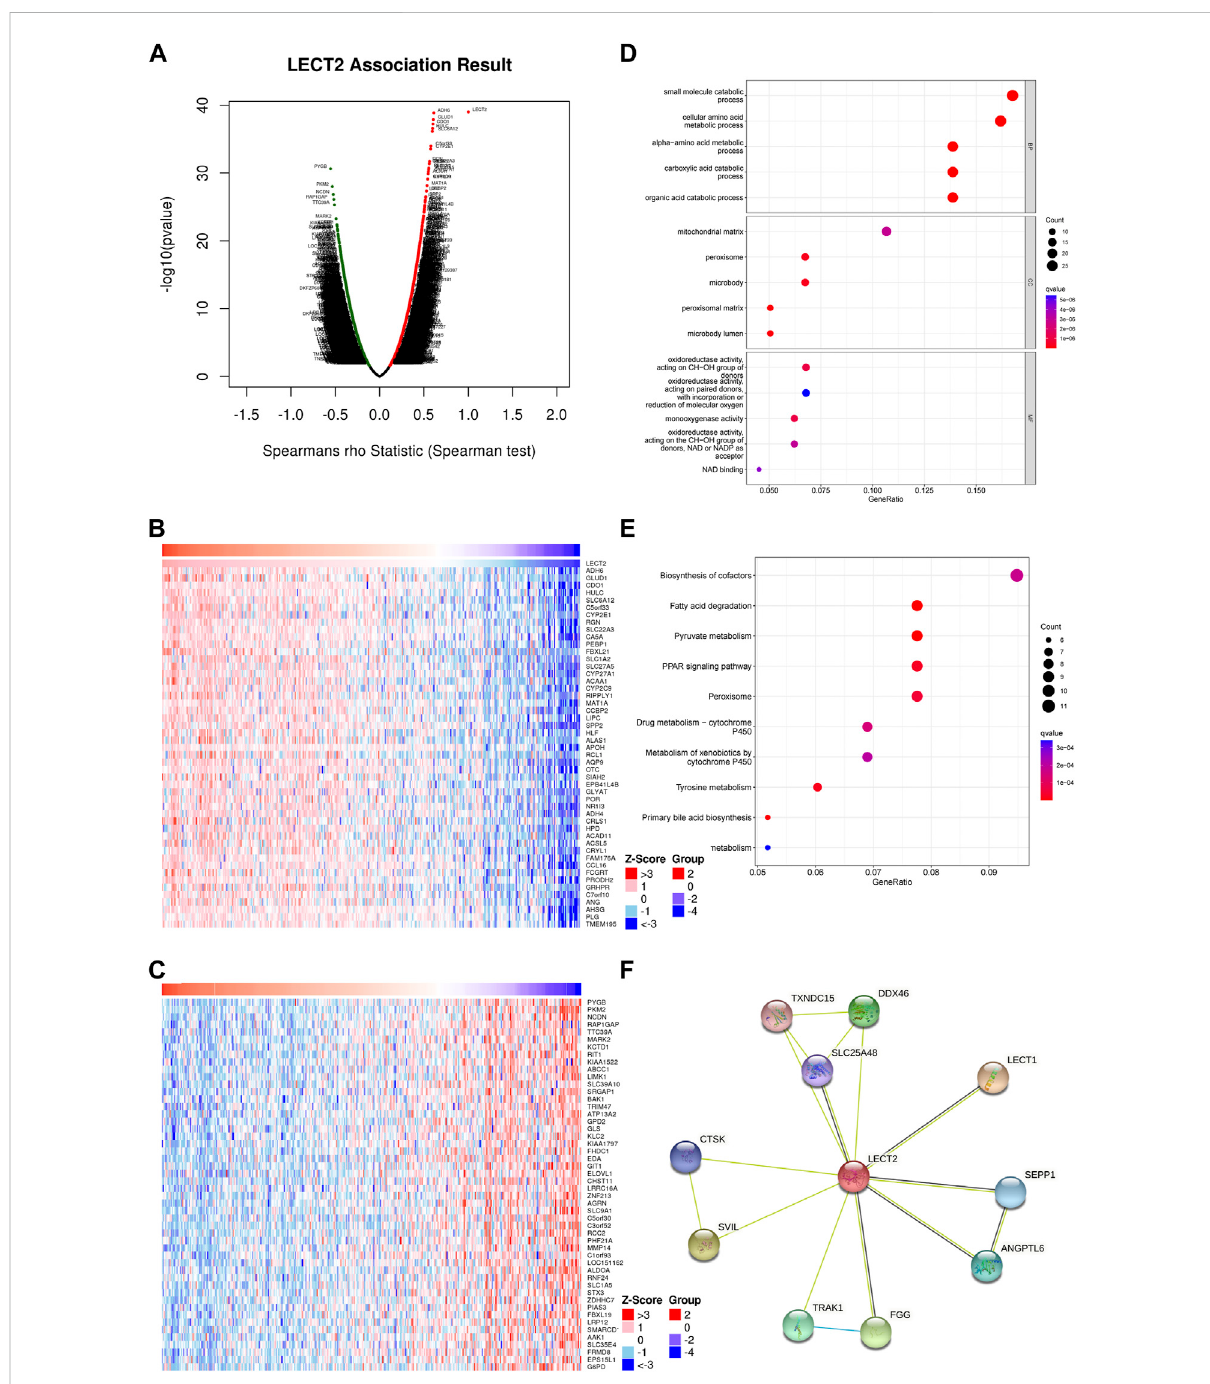
FIGURE 5 Enrichment analysis and PPI analysis of LECT2 in HCC. (A) Genes highly correlated with LECT2 identi fi ed in HCC by Spearman correlation analysis (B) Top50genespositivelycorrelatedwithLECT2inHCC. (C) Top50genesnegativelycorrelatedwithLECT2inHCC (D) Enrichmentofgene ontology (GO) for genes correlated with LECT2. (E) Enrichment of Kyoto Encyclopedia of Genes and Genomes (KEGG) for genes correlated with LECT2 (F) Protein-protein interaction network of